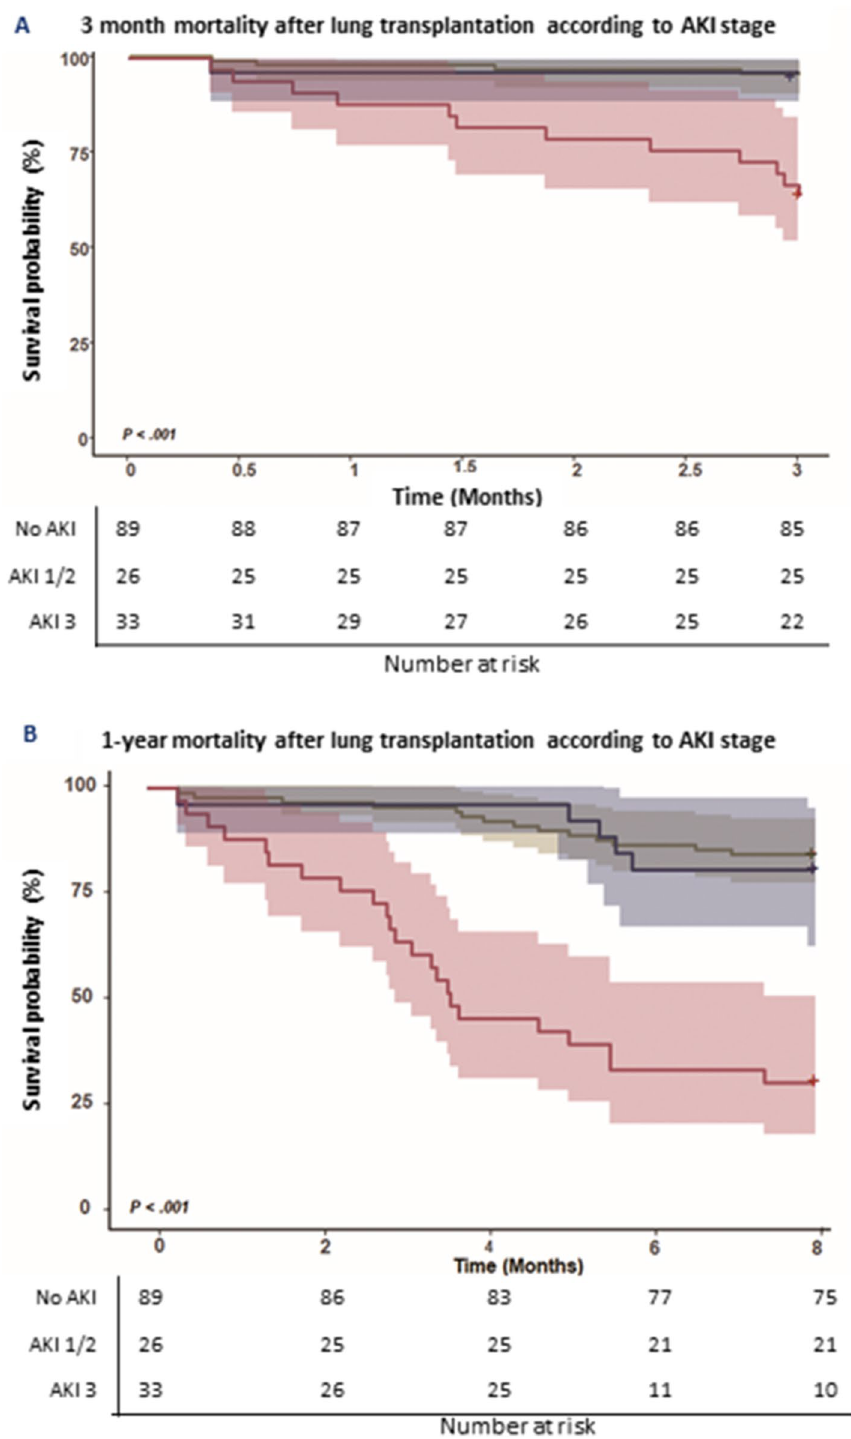
Figure 2. Kaplan–Meier survival analysis of lung transplant recipients stratified by AKI stage: 3-month mortality A, and 1-year mortality B. ( A ) Kaplan–Meier 3-month mortality of lung transplant patients stratified by AKI stage. ( B ) Kaplan–Meier 1-year mortality of lung transplant patients according to AKI stage. AKI acute kidney